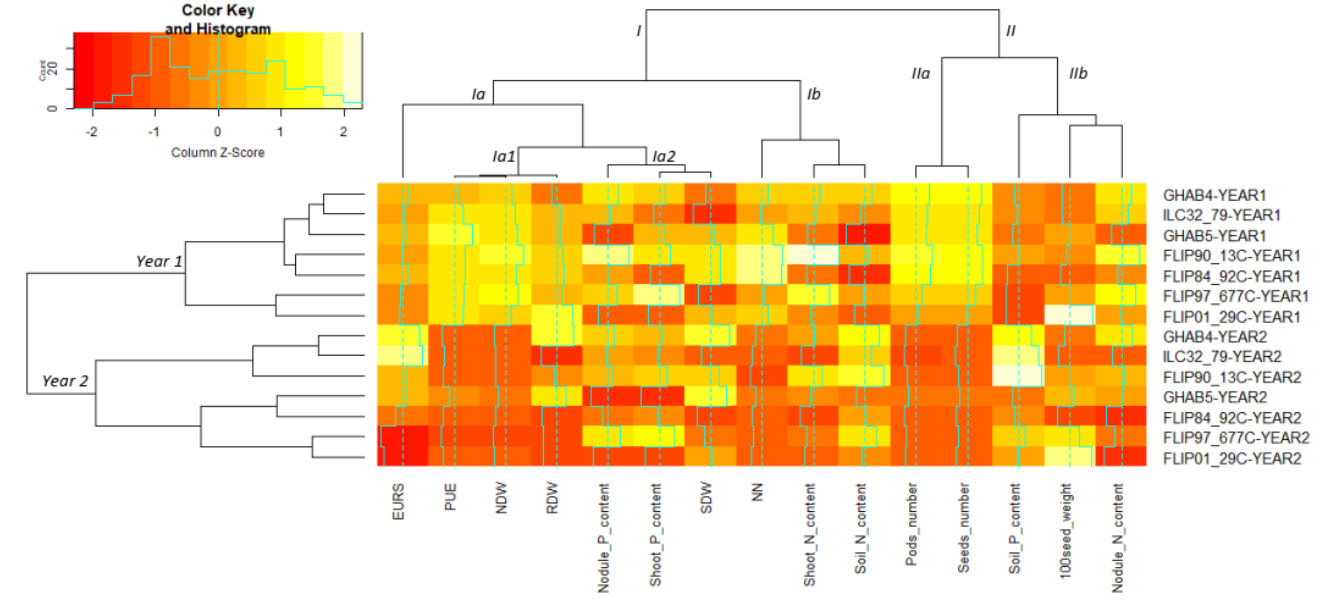
Figure 6. Hierarchical clustering analysis of the 15 plant functional parameters of the seven chickpea genotypes through two growing seasons, from 2018 to 2019, grown in field conditions under a low- soil P availability. The hierarchical clustering for the chickpea genotypes, based on the plant biomass (SDW, RDW), yield components (pod and seed numbers), nutrient acquisition (P and N content in the nodules and shoots), the nodulation (nodules number and biomass, rhizobial symbiosis efficiency), and the soil N and P availability parameters, was computed, based on the Pearson correlations. Z-scores were calculated and used to generate the heatmap. Dendrogram on the left shows the relationships between the chickpea genotypes and the growing seasons, according to the different plant functional parameters. Dendrogram on the upper part shows the relationships between the parameters, according to the performance pattern of the chickpea genotypes. Yellow color indicates a high value and the orange color indicates a low value. The graph was obtained using the heatmap.2 function of the gplot package of R software. SDW, shoot dry weight ; RDW, root dry weight ; NDW, nodule dry weight ; NN, nodule number; PUE, phosphorus use efficiency and EURS, efficiency in the use of the rhizobial symbiosis.